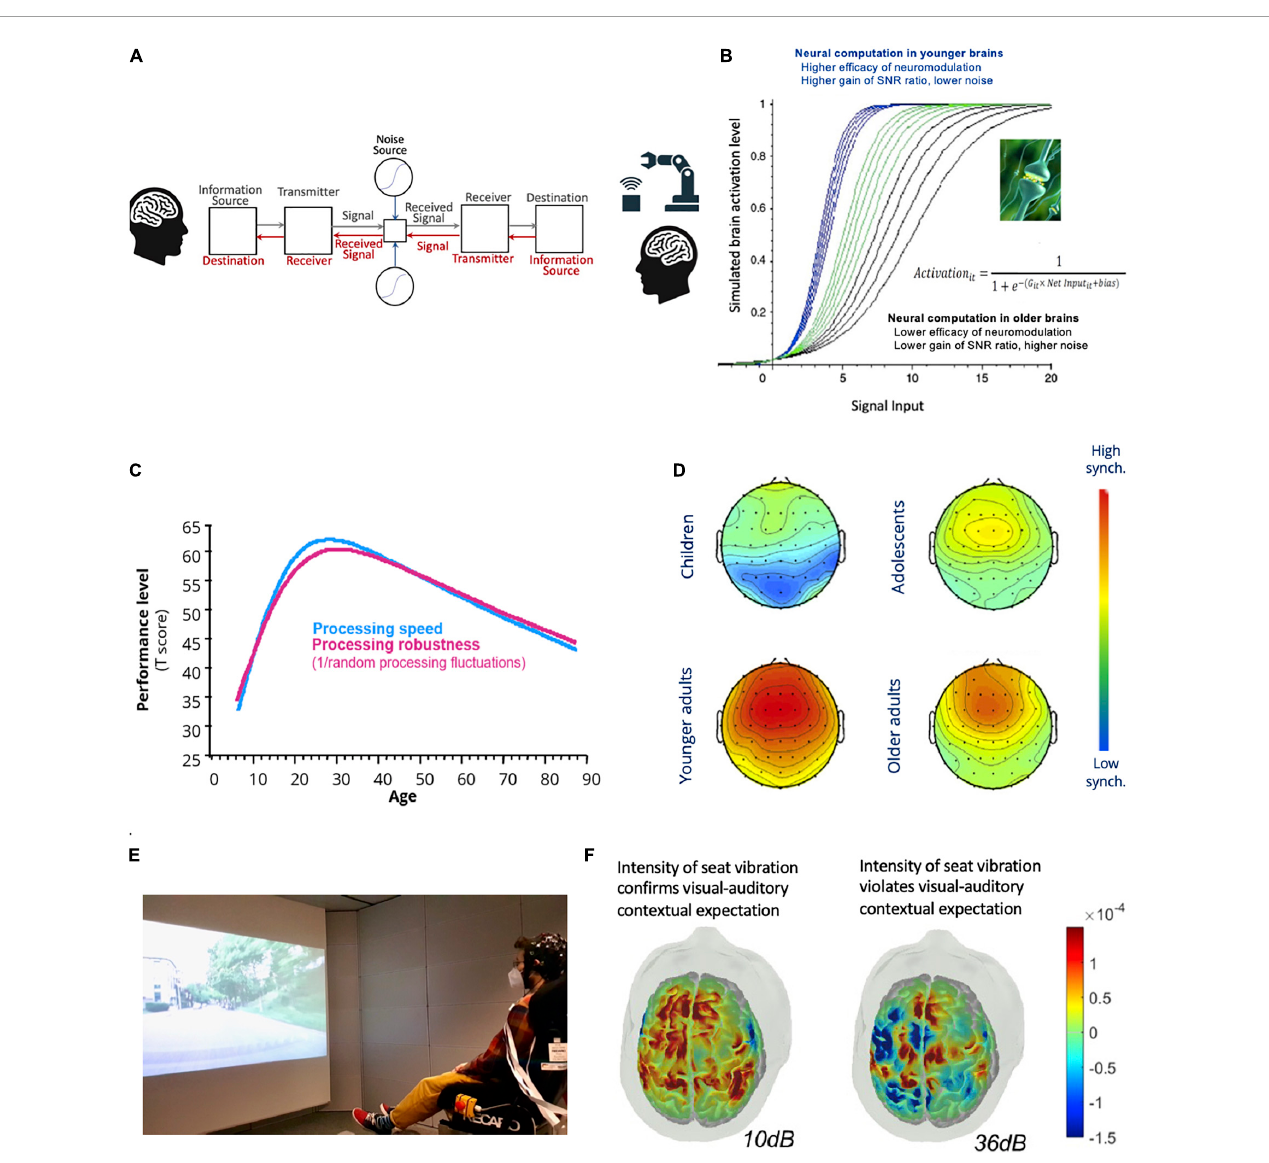
FIGURE2 Interfaces for transdisciplinary research. (A) Digitally embodied closed-loop human-machine or human-human communication system in the presence of physical and biological noise. (B) Varying values of the G parameter of artificial neurons simulates dopaminergic neuronal gain control of neural information processing in younger and older adults (see text and Li et al., 2001, 2006 for details). (C) The speed and robustness of cognitive and perceptual processing vary across the lifespan [see text for details; figure plotted with data from the author’s work Li et al. (2004)]. (D) Inter-trial phase coherence of EEG frontal theta activities differs across the lifespan [see text for details. Images adapted from Papenberg et al. (2013), with permission, Copyright Elsevier 2013]. (E) Assessing cortical processes of contextual expectancy modulation of tactile perception using fNIRS in a virtual driving environment with audio-visual scenes of different road types (shown here is a scenario of driving on smooth road). (F) Plausible vibrotactile stimulations at a lower intensity but confirm with contextual expectation based on audio-visual information in the virtual driving scene elicited greater cortical responses in the sensorimotor cortex than implausible stimulations at a higher intensity [see text for details; images in (E) and (F) are adapted with permission from Kang et al. (2022), Communications Biology, 5:1360,